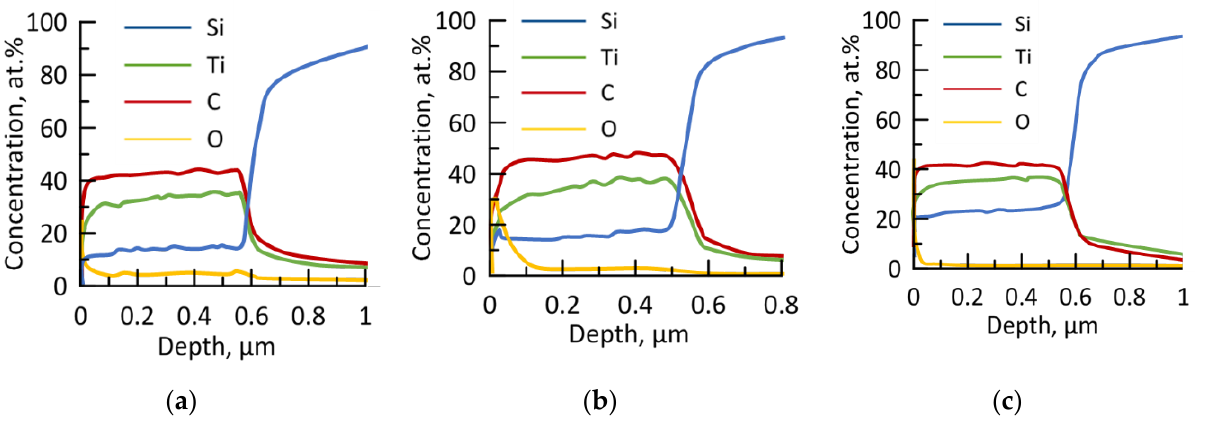
Figure 2. The GDOES profiles of the coatings 1 ( a ), 2 ( b ), and 3 ( c